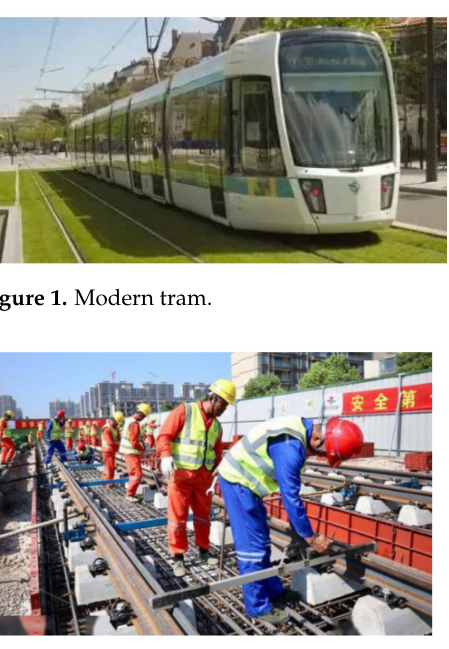
Figure 2. Tram track construction site.